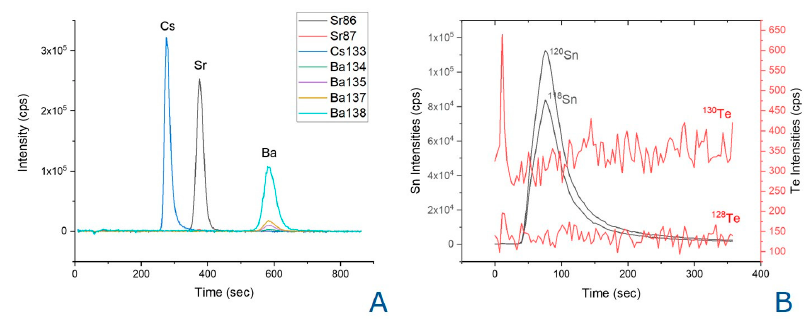
Figure 6. SeaFAST with ICP-DRC-MS time resolved signal of ( A ) a standard solution of Cs, Sr, and Ba (500 pg g − 1 ) on the Ion Pac CS12A column using methanesulfonic acid (MSA) 20 mmol L − 1 as eluent ( B ) in HNO3 1 v / v % using a Nobias chelate-PA1 chelating column using as eluent Acetate 0.5 mol L − 1 pH 6.